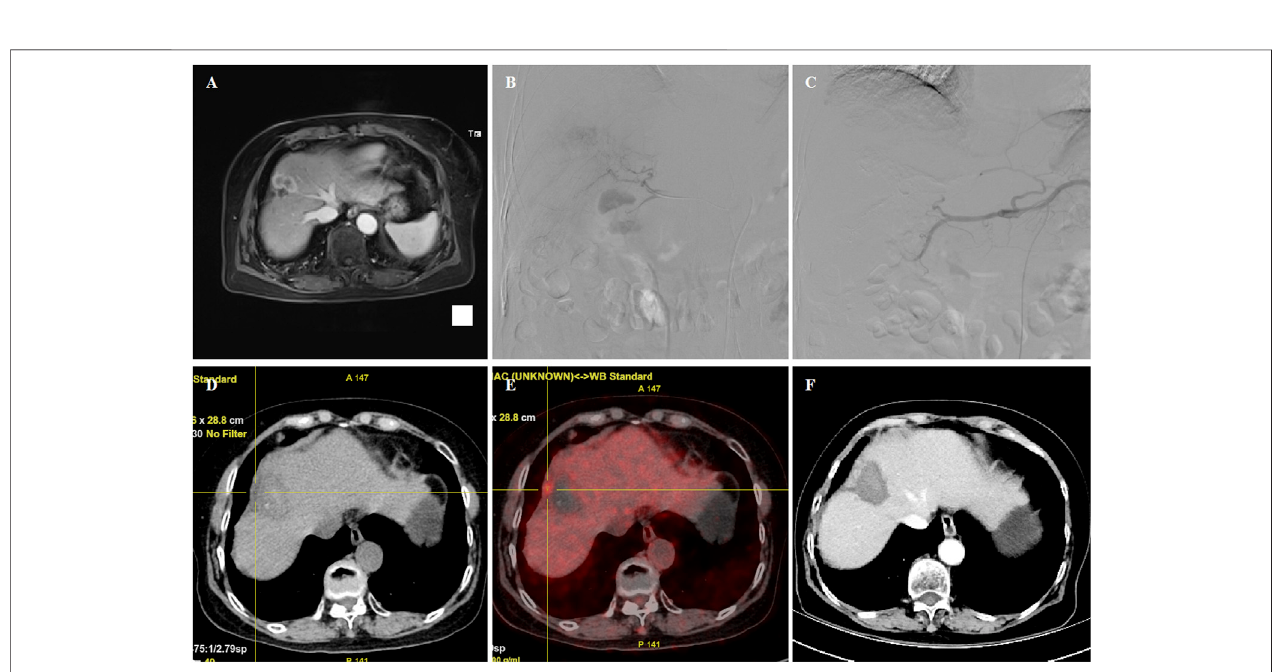
FIGURE 2 | 54 years female patient treated with CalliSpheres beads for advanced primary HCC. (A) CT revealed a tumor in the right lobe and the obstructed bile duct. (B – C) Tumor artery was super selectively incubated and embolized by 100 – 300 μ m oxaliplatin-loaded beads. (D) MR revealed a shrunk tumor 4.6 months after DEB-TACE. (E – F) Tumor was resected 4.9 months after DEB-TACE, and no residual tumor was shown by pathological examination.